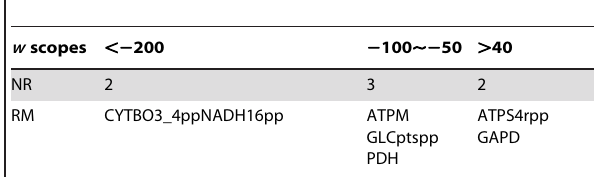
Table 3. w scopes, number of reactions (NR) and reaction names